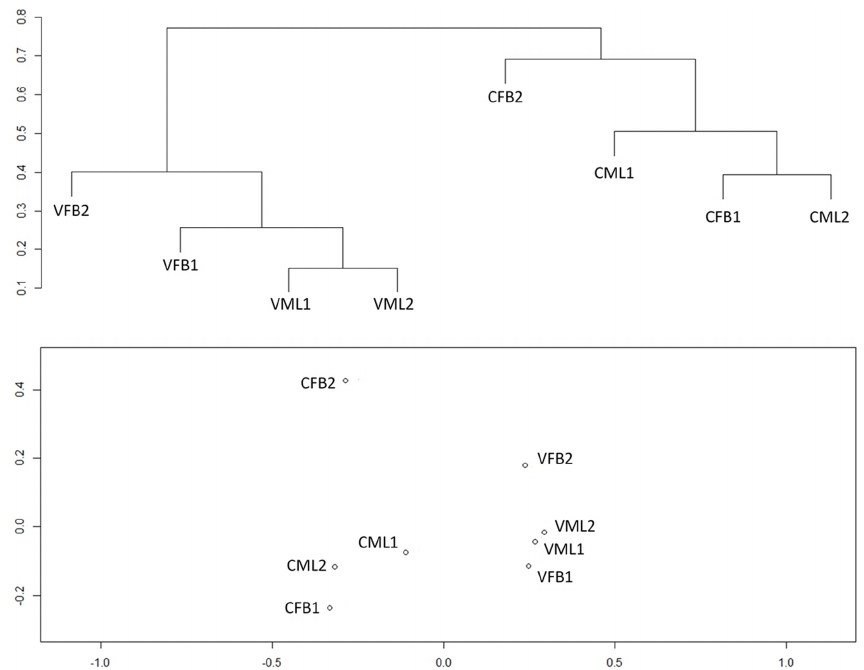
Figure 2. Bray‐Curtis similarity studies of the biological samples (top: cluster analysis, bottom: principal coordinates